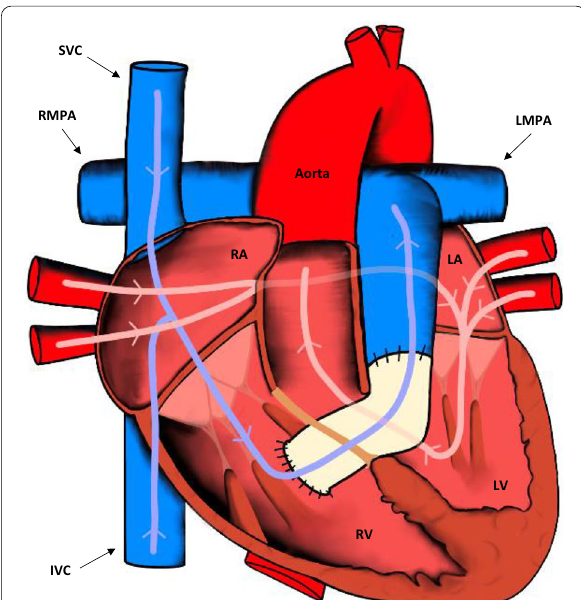
Fig. 4 Appearances of the heart after the Rastelli procedure. The VSD is closed and an RV to pulmonary artery conduit is placed. IVC: inferior vena cava; LA: left atrium; LV: left ventricle; LMPA: left main pulmonary artery; RMPA: right main pulmonary artery; RA: right atrium; RV: right ventricle; SVC: superior vena cava